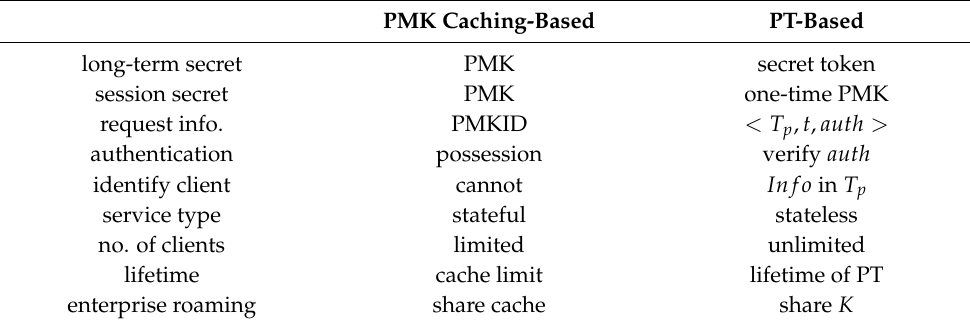
Table 1. Comparison of features; PMK caching-based vs. PT-based re-associations. PMK Caching-Based PT-Based long-term